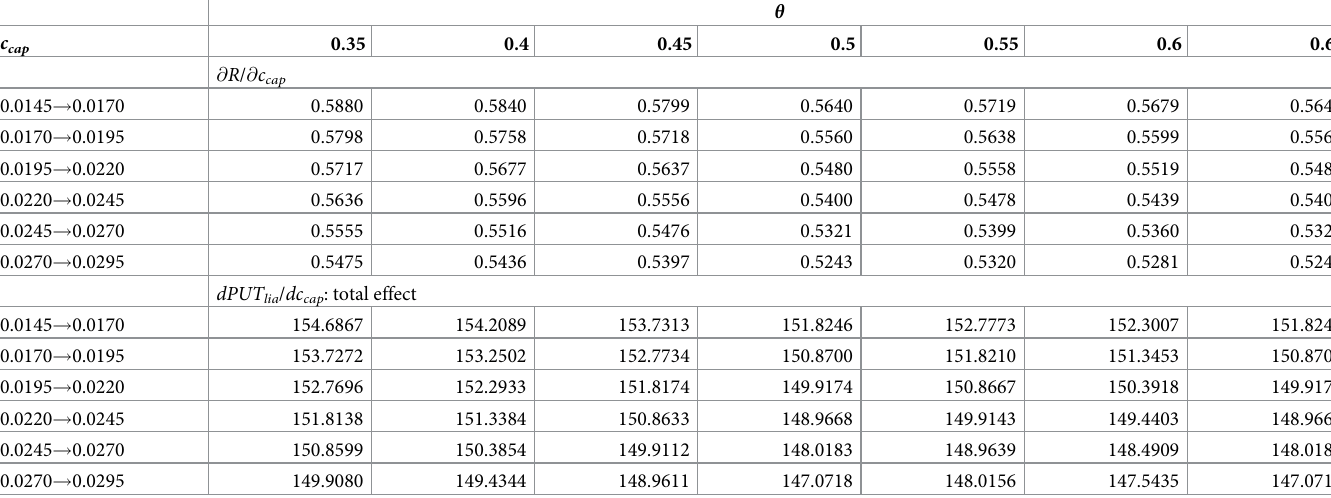
Table 3. Responsiveness of the optimal guaranteed rate and the insurer’s liabilities ( PUT lia ) to c cap at various levels of green loans ( θ